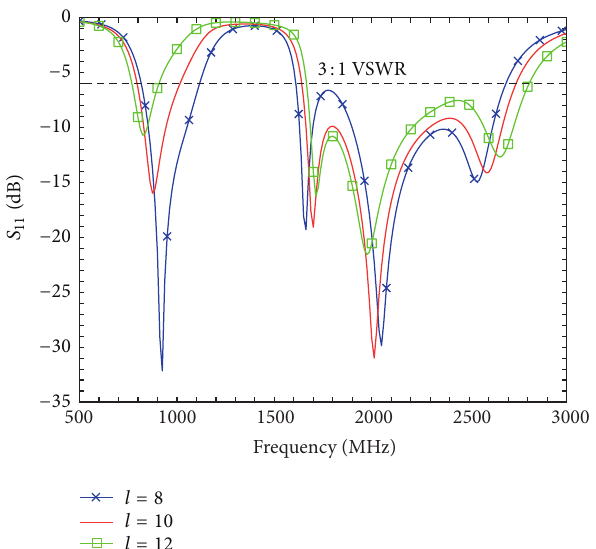
Figure 6: Simulated 𝑆 11 as a function of the length 𝑠 of the short strip; other dimensions are the same as given in Figure 1 (unit: